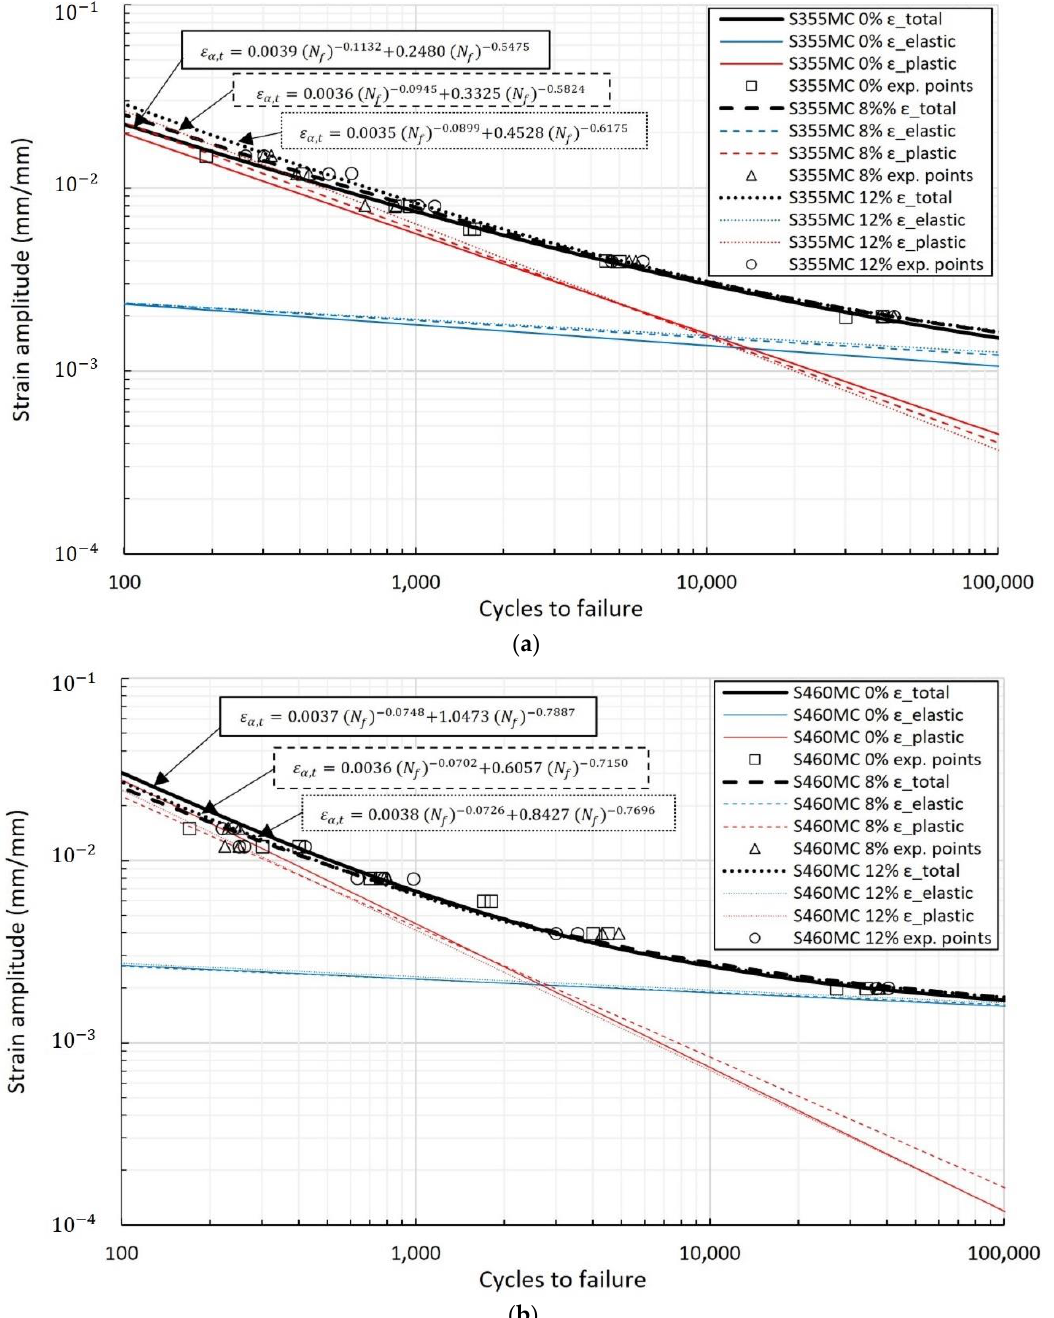
Figure 2. Strain – life curves showing total, elastic, and plastic components for ( a ) the S355MC and ( b ) the S460MC steel.